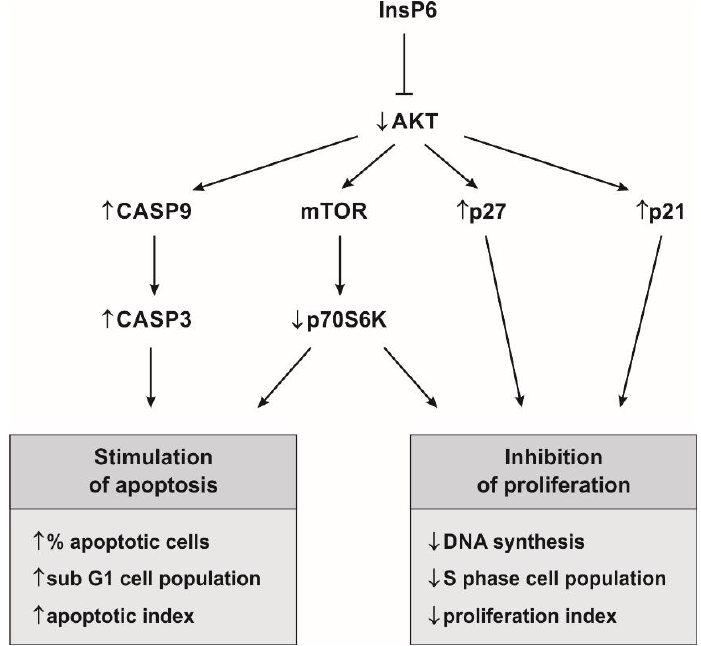
Figure 9. Scheme of InsP6 molecular pathways and targets in anti-cancer activities.